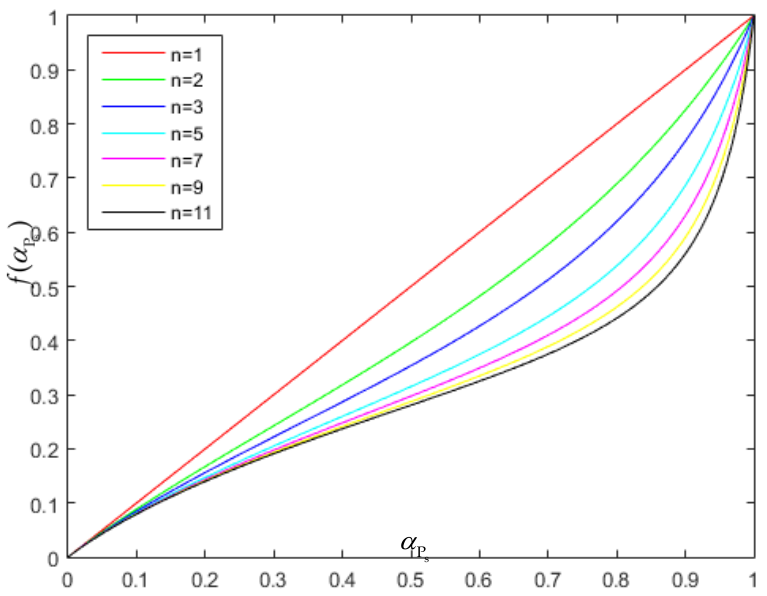
) with α ( α ) is defined in Equation (12). α P s and n . f P s s